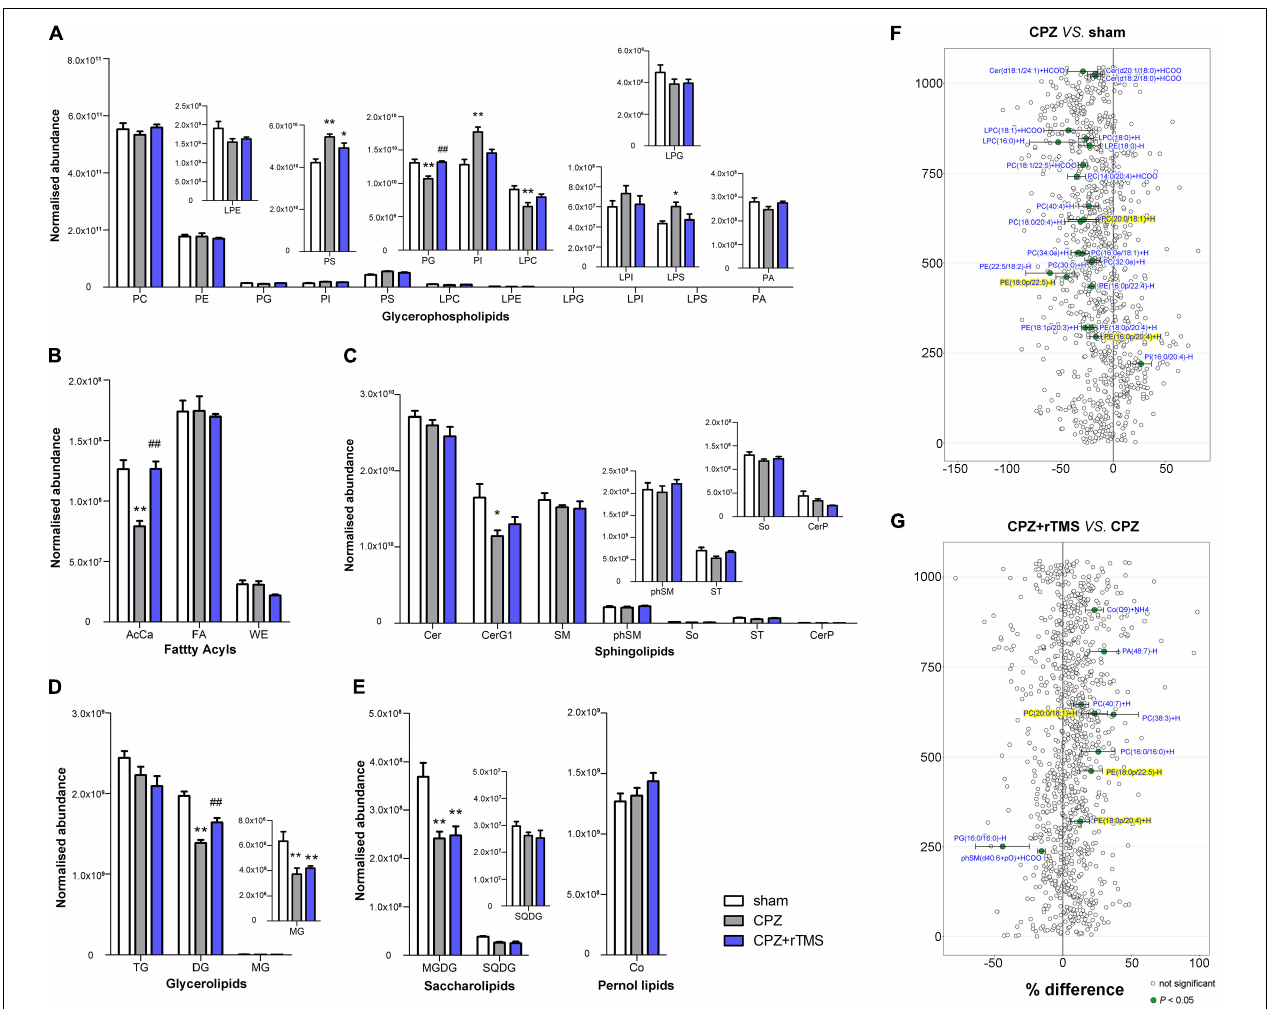
FIGURE 4 | Alterations in lipidomic profiles and the characterization of lipids in the PFC of mice in each group. Six main lipid classes were analyzed: (A) glycerophospholipids, (B) fatty acyls, (C) sphingolipids, (D) glycerolipids, (E) saccharolipids, and pernol lipids. Lipids showing low levels results have been enlarged in insets. (F,G) Forest plots of individual lipids in the PFC of mice in the CPZ group expressed as a percent difference compared to shams, CPZ + rTMS group expressed as a percent difference compared to the CPZ group. Molecules indicated in green represent significant differences in individual lipids ( P < 0.05). Lipids highlighted in yellow indicate lipids that were modulated in a contrary direction compared to that in the CPZ group. PC, phosphatidylcholine; PE, phosphatidylethanolamine; PG, phosphatidylglycerol; PI, phosphatidylinositol; PS, phosphatidylserine; LPC, lysophosphatidylcholine; LPE, lysophosphatidylethanolamine; LPG, lysophosphatidylglycerol; LPI, lysophosphatidylinositol; LPS, lysophosphatidylserine; PA, phosphatidic acid; AcCa, acylcarnitine; FA, fatty acid; WE, wax esters; Cer, ceramides; CerG, glucosylceramides; SM, sphingomyelin; phSM, sphingomyelin (phytosphingosine); ST,